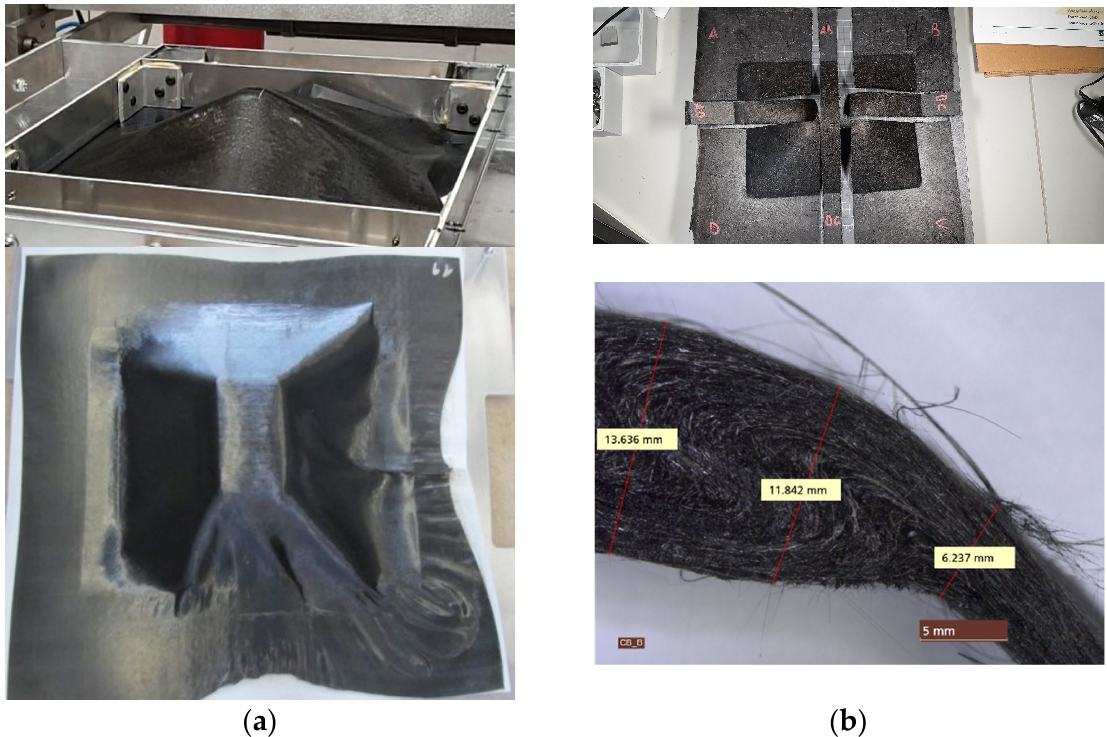
Figure 20. ( a ) Vacuum thermoforming of a multiaxial endless CFRP sheet under non-optimal conditions. ( b ) Vacuum thermoformed short CFRP sheet and resulting lofting effect.